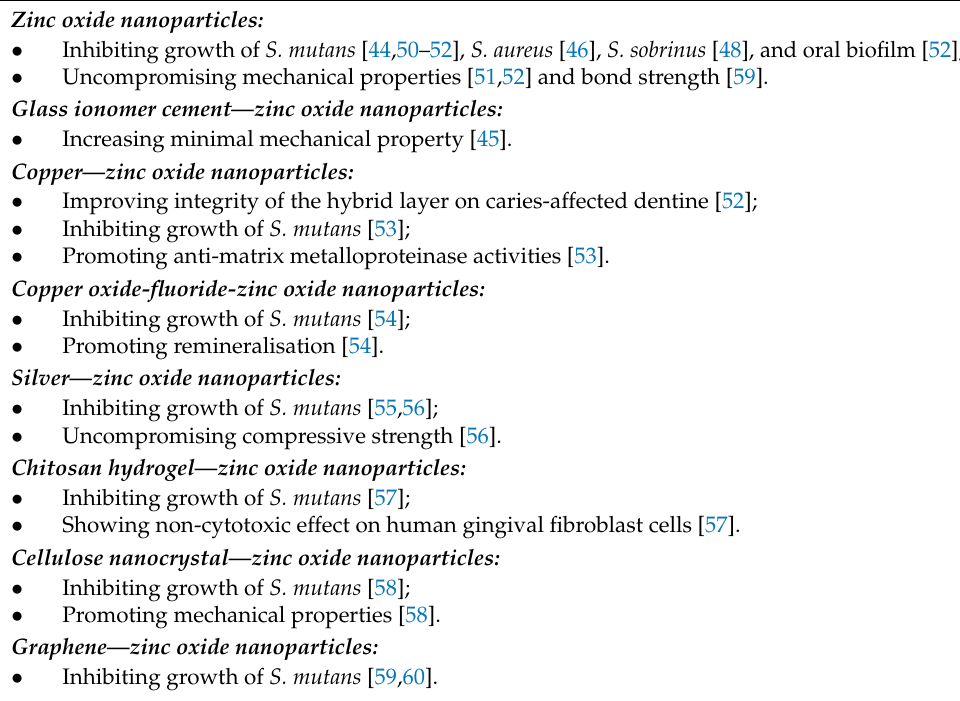
Table 2. Properties of zinc nanoparticle and their related products in caries